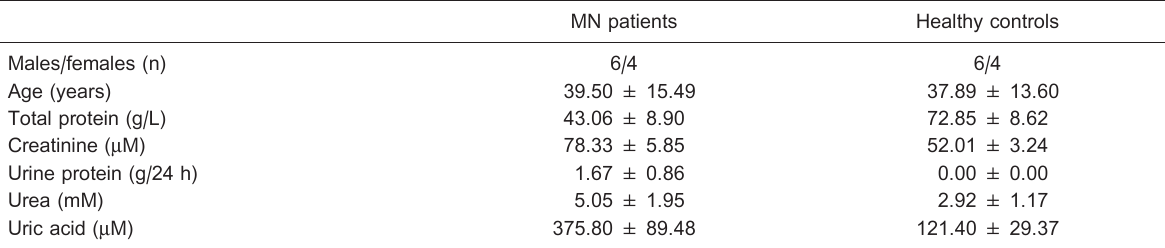
Table 1. Demographic and clinical characteristics of the patients with membranous nephropathy (MN) and controls.